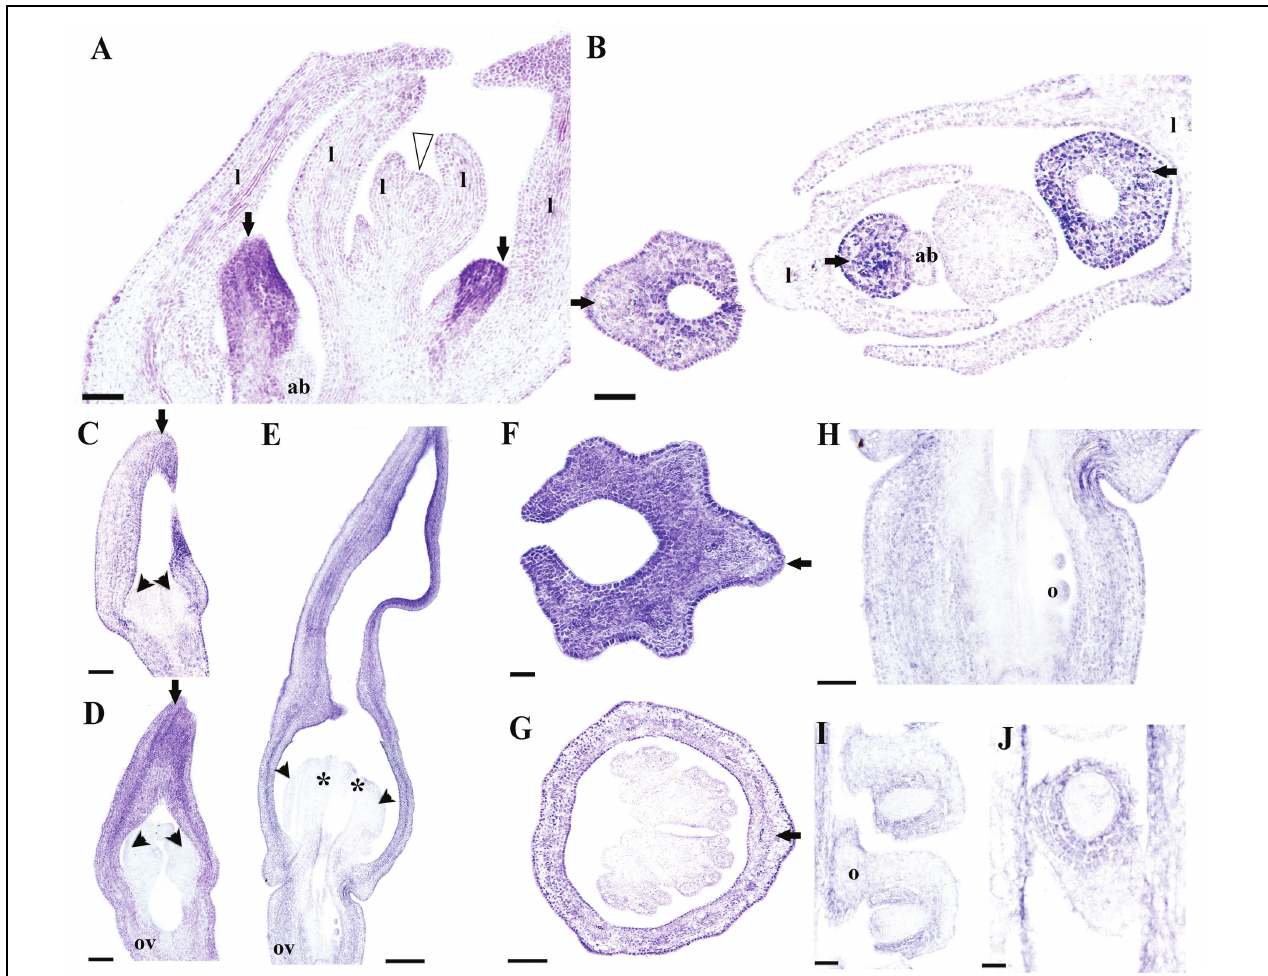
FIGURE 8 | In situ hybridization of AfimAGL6 . (A,B) Flowering shoot apex in longitudinal (A) and cross (B) sections; note onset of expression in the perianth. (C–E) Successive stages S3–S6 showing stamen initiation at S3 (C) , stamen elongation at S4 (D) , and ovary development with ovule differentiation at S7 (E) ; note expression restricted to perianth and ovary. (F,G) Cross- sections of a floral bud at the limb (F) and the utricle/gynostemium (G) levels; note expression restricted to the perianth. (H) Longitudinal section of the ovary. (I,J) Longitudinal (I) and cross (J) sections of the ovules; note expression in the ovary wall and the integuments. Black arrows indicate medial sepal; black arrowheads indicate anthers; white arrowhead indicates shoot apical meristem; asterisks indicate stigmas; ab, accessory bud; l, leaf; o, ovules; ov, ovary. Scale bars: (A,B,E) : 100 μ m; (C,D,F,G) : 50 μ m; (H–J) : 60 μ